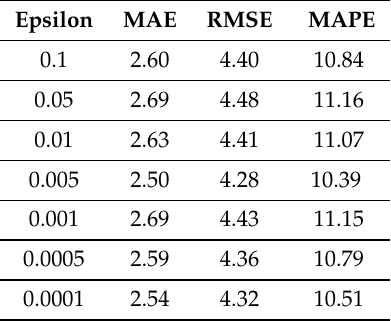
Table 3. Prediction performance according to the convergence condition ( (cid:101) )